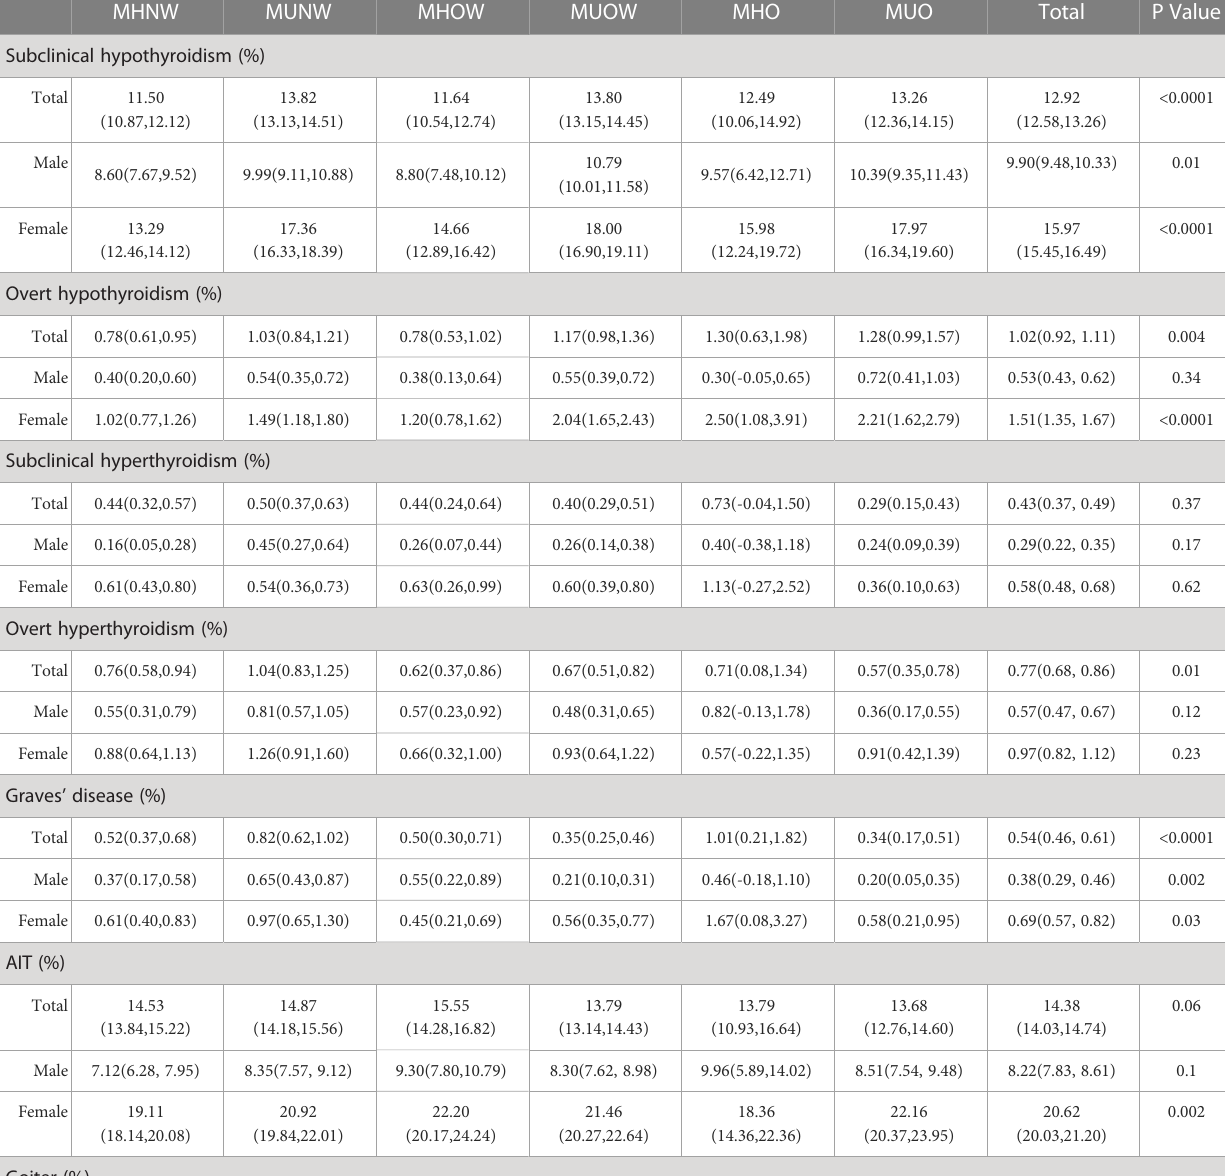
TABLE 3 Prevalence distributions of thyroid disorders by metabolic obesity phenotype and